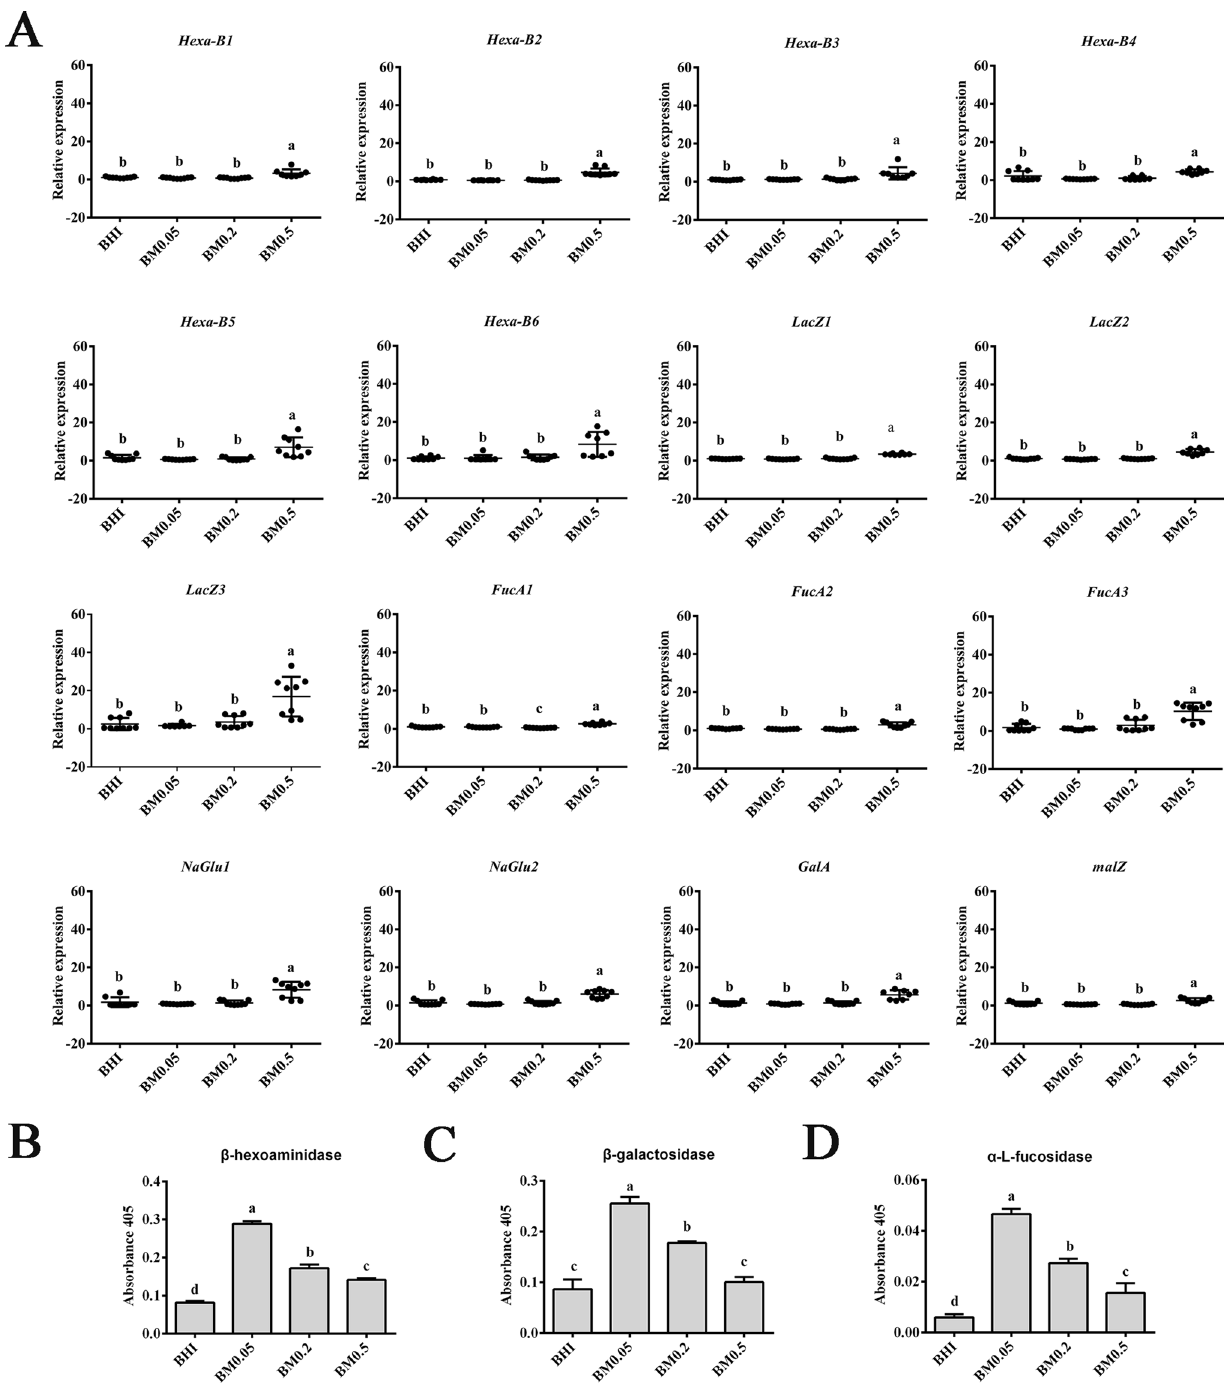
Figure 4. qRT-PCR and activities of mucin degrading enzymes. ( A ) qRT-PCR results; ( B ) and ( C ) Reactions were incubated with 4-nitrophenyl-N-acetyl-β-d-glucosaminide or 4-nitrophenyl-β-d-galactopyranoside in PBS buffer (50 mM, pH 7.0) for 1 h at 37 °C; ( D ) α-l-fucosidase activities were measured by incubation with 2-chloro-4-nitrophenyl-α-l-fucopyranoside in PBS buffer (50 mM, pH 7.0) for 2.5 h at 37 °C. All these enzymatic reactions were stopped by adding 100 μl 1 M Na 2 CO 3 and the absorbance was read at 405 nm. “a” “b” “c” and “d” indicate significant differences in enzyme